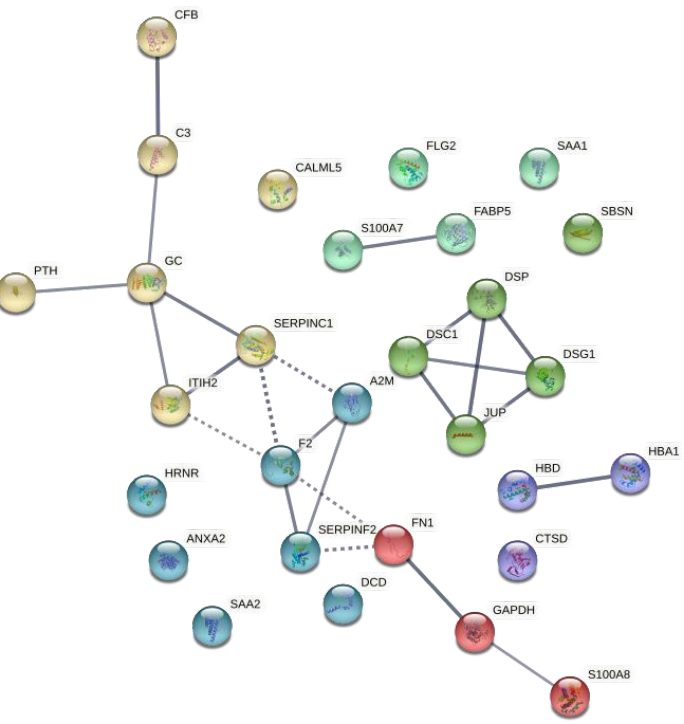
Figure 2. Protein–protein interaction network of the differentially expressed proteins after 6-month treatment with teriparatide. The edges show protein–protein interactions with predicted functional partners. Edges have different colors according to their clustering with k means with input number 6. All lines represent known protein–protein interactions with high confidence. Dot lines show high confidence interactions between different clusters.